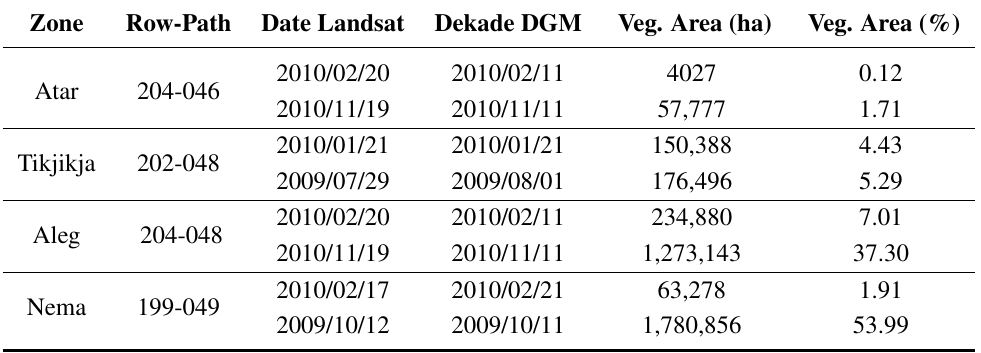
Table 1. Characteristics of the images for the eight study sites including the acquisition dates of the Landsat images and of the Dynamic Greenness Maps (DGM) along with the vegetated area (Veg. Area). There is a large dominance of the non-vegetation class in the dry season and in the northern